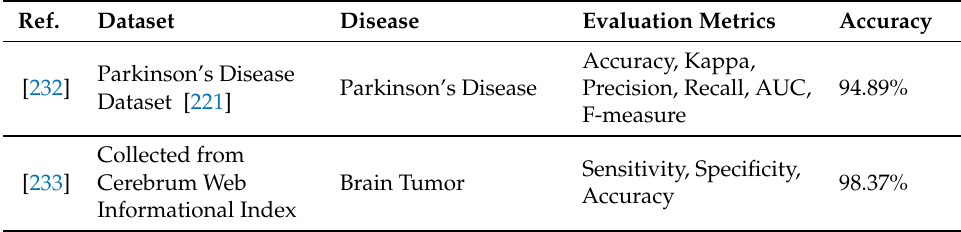
Table 12. RF classifier result analysis on various NDs.